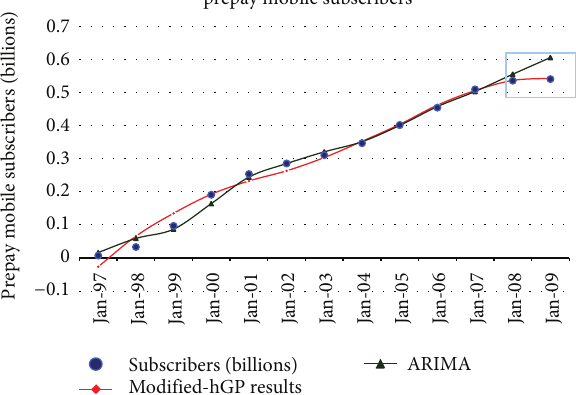
Figure 33: Comparison of the forecasting performances of modified-hGP with ARIMA model (forecast window—2